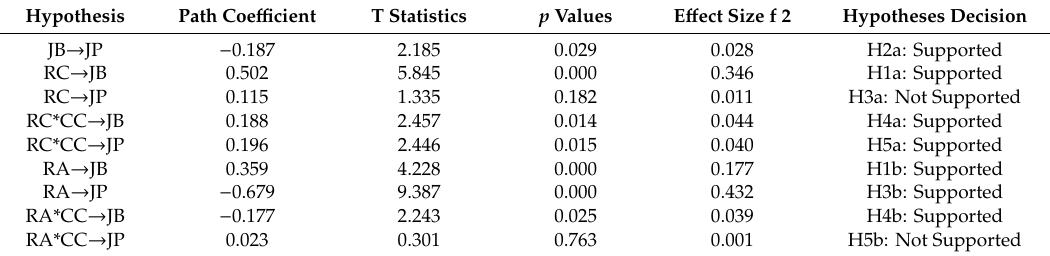
Table 4. Hypotheses decision table.